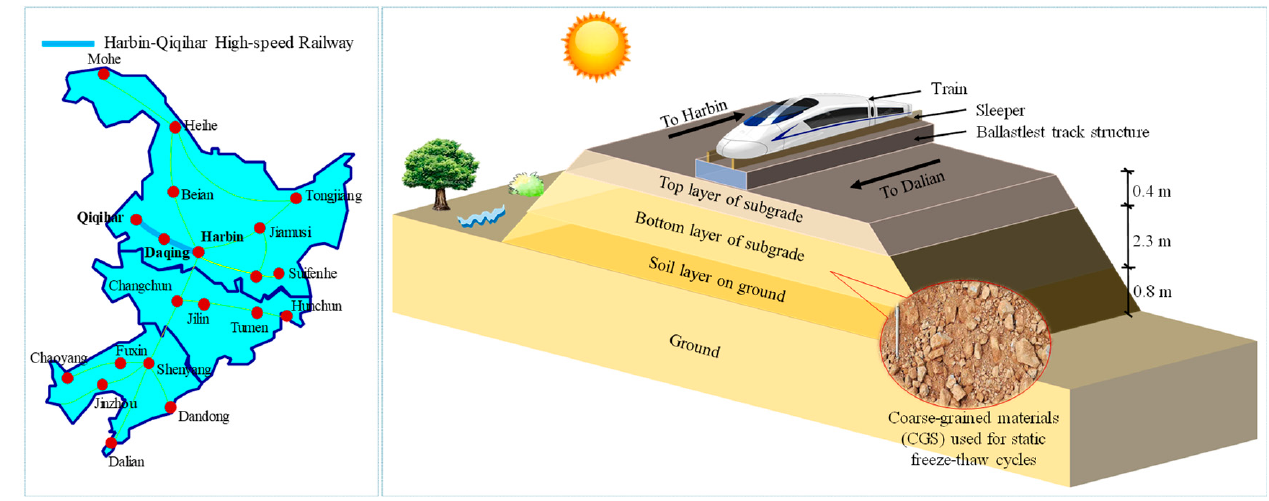
Figure 1. The schematic construction of the Harbin ‐ Qiqihar high ‐ speed railway in Northeast China.